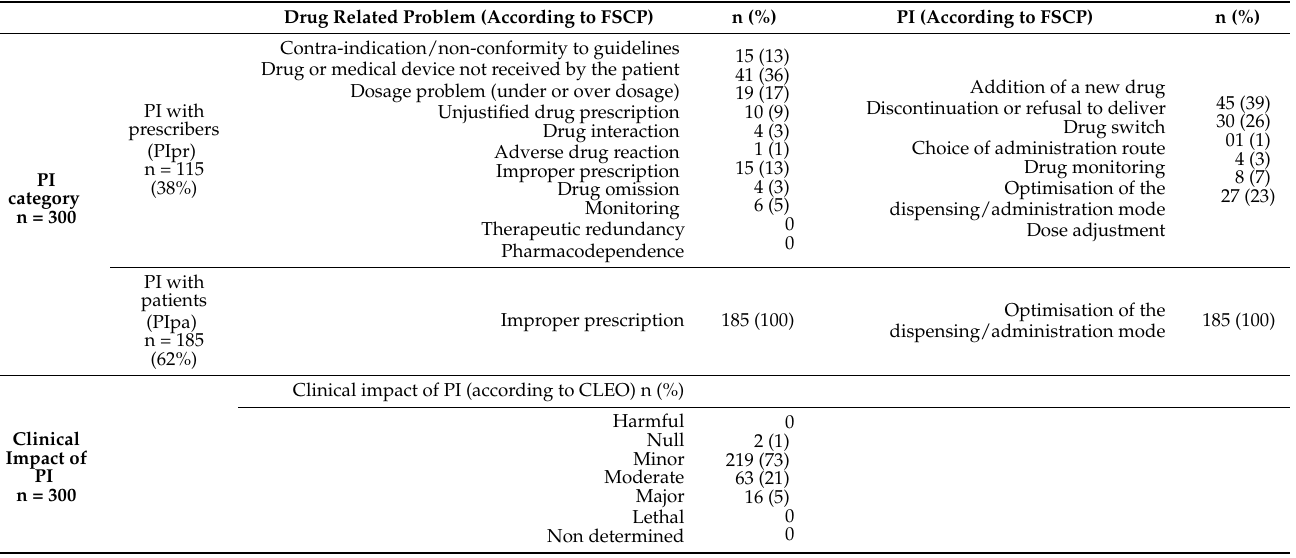
Table 3. Description of pharmacist interventions (PIs).